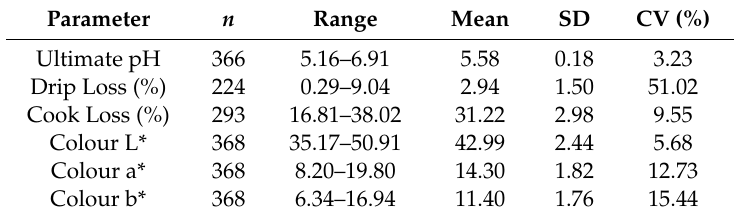
Table 1. Ranges, mean, standard deviations and coe ffi cient of variance of physico-chemical traits of all beef